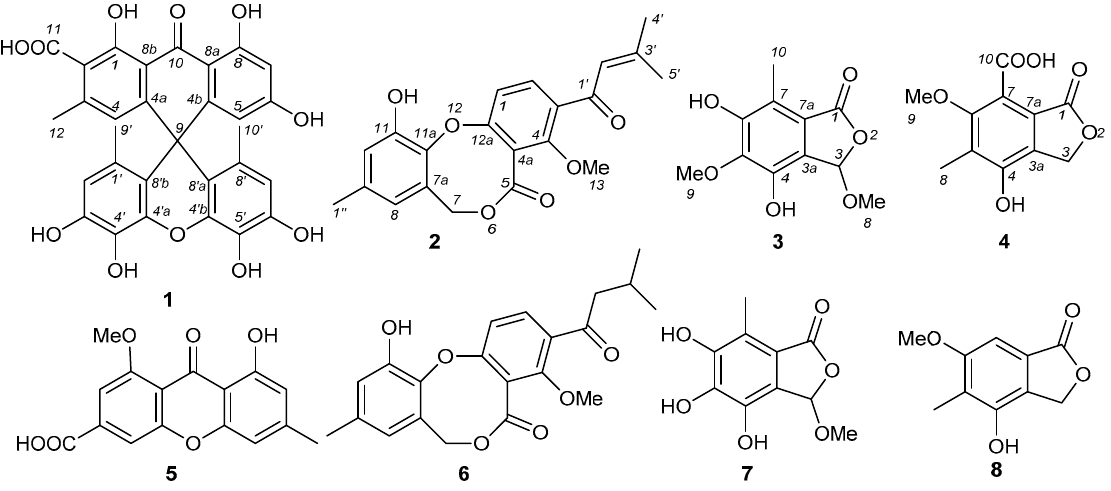
Figure 1. Chemical structures of 1 – 8 .